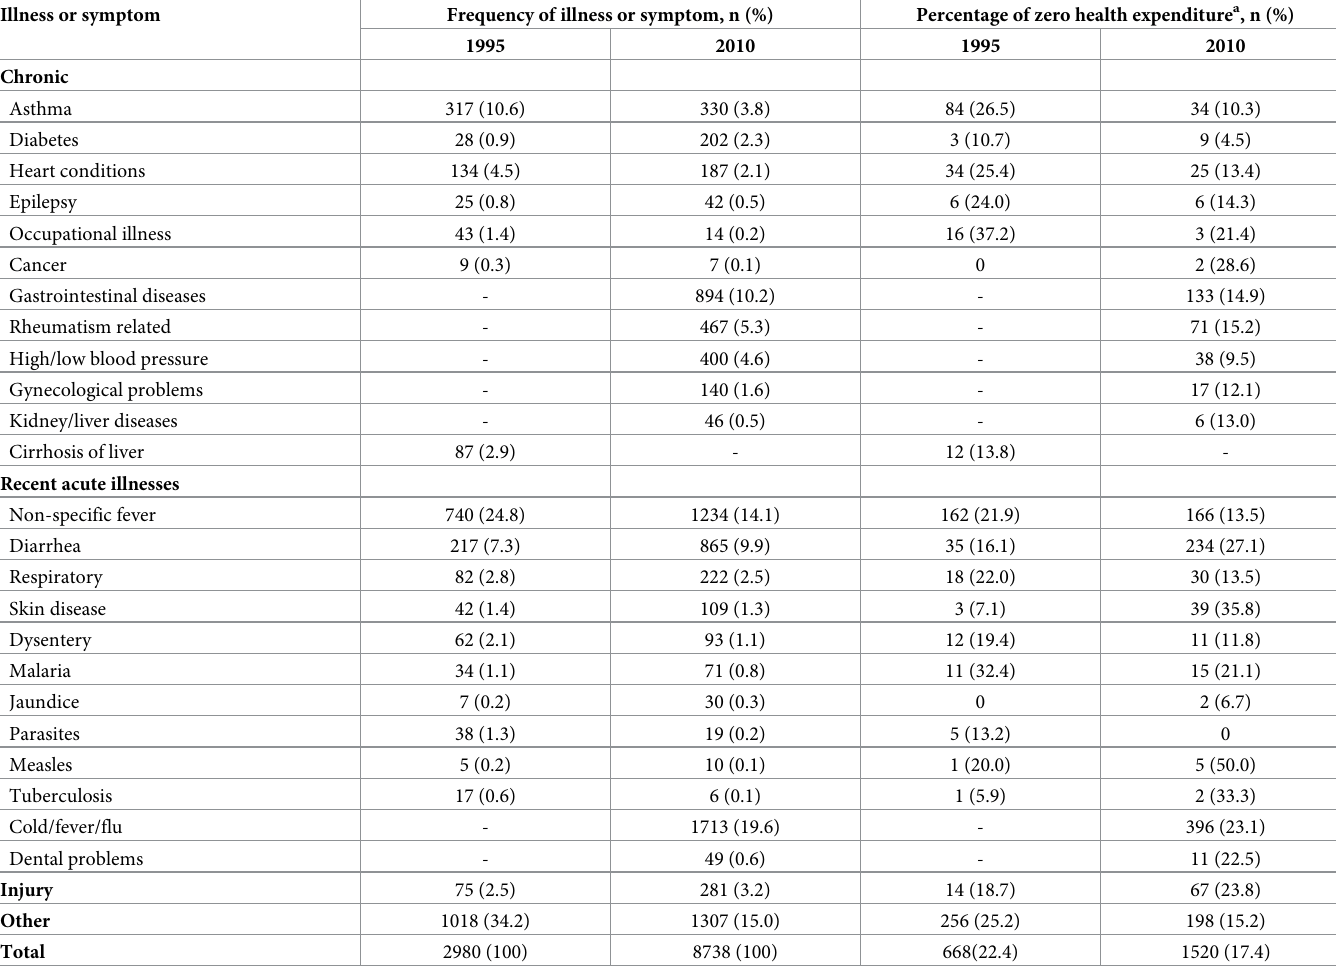
Table 3. Frequency of illness/symptom and percentage of zero health expenditure in Nepal